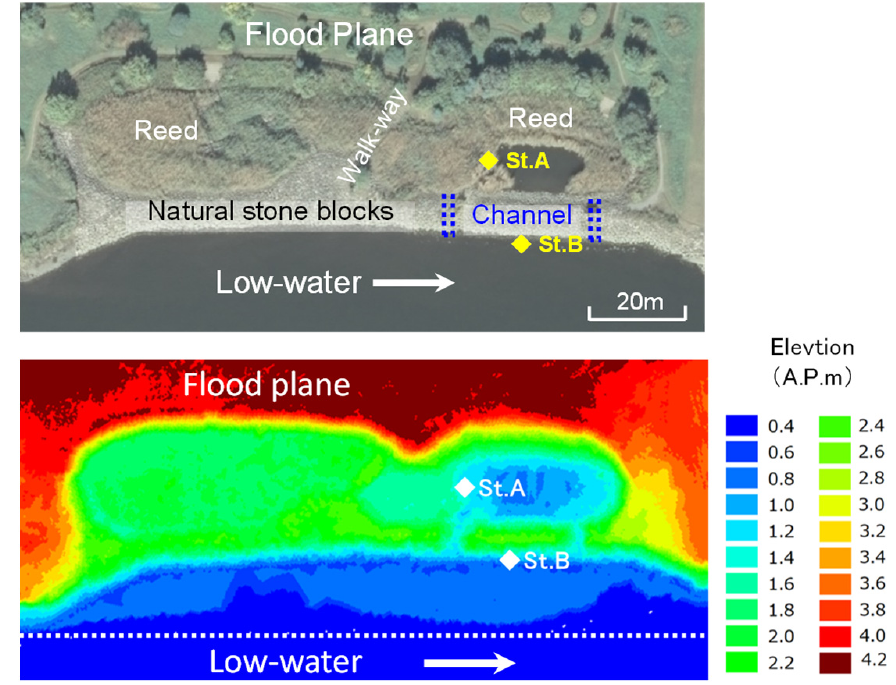
Figure 3. A plane view of the riverine marsh and elevation contour.